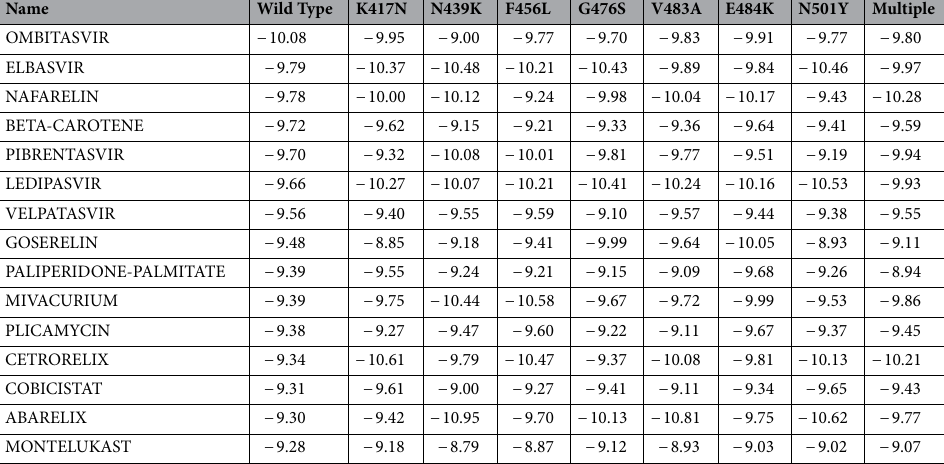
Table 2. Affinity prediction of the top-20 drug candidates for repurposing against Spike wild type and for each variant evaluated ( i.e. , K417N, N439K, F456L, G476S, V483A, E484K, N501Y, and Multiple = N501Y + K417N + E484K). 1 Number of clinical trials reported related to COVID-19 by Mapped Drug Intervention at the ClinicalTrials.gov (accessed on 2020-09-03, https ://clini caltr ials.gov/ct2/covid _view/ drugs